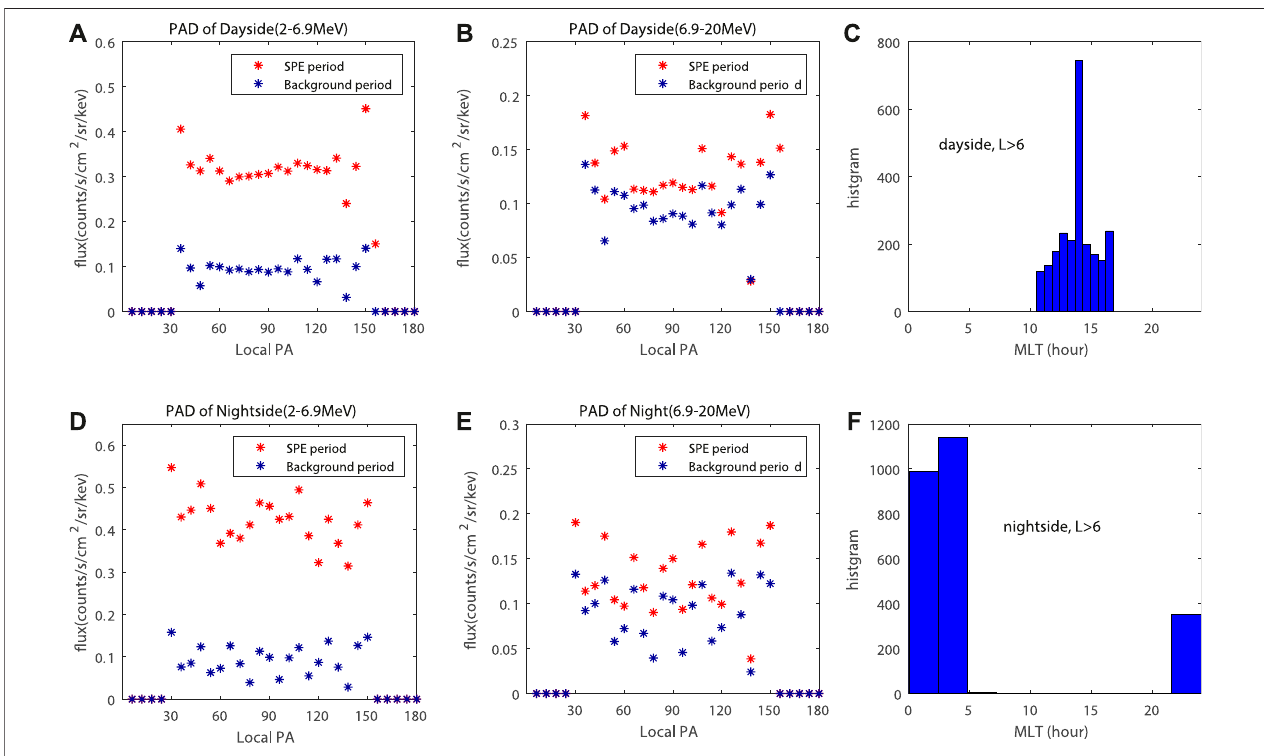
FIGURE 8 | Pitch angle distribution of protons in the outer radiation belt during SPE, (A) and (B) at dayside, (D) and (E) at nightside. Red dots indicate fl ux distribution during the SPE period. Blue dots indicate quiet time. (C) and (F) are the local time covered by ZH-1.